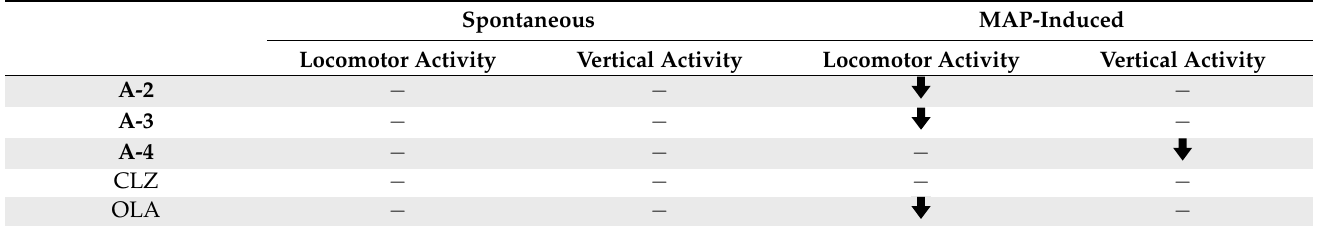
Table 1. Effects of apocynin-tandospirone derivatives and antipsychotic drugs on locomotor and vertical activity.